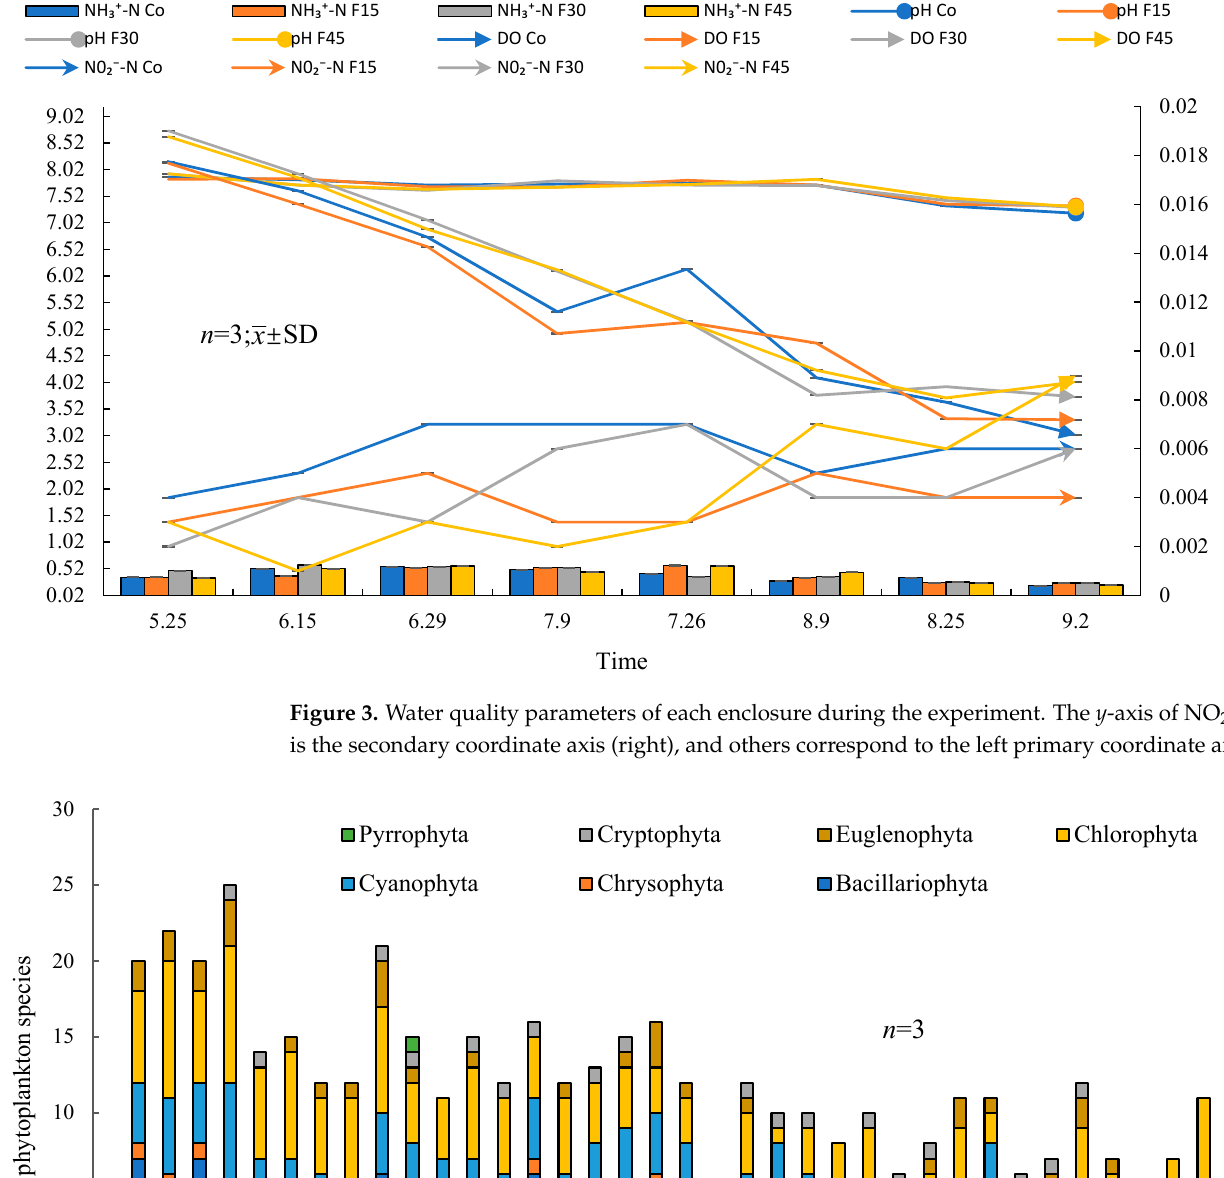
Figure 4. Species of phytoplankton observed in different treatment groups during the experiment. The phytoplankton diversity in each group was analyzed using the Shannon–Wiener diversity index (Figure 5), with an overall average of 1.07. The diversity index of the Co group was 0.59 to 1.43, with an average of 1.03. The diversity index of the T15 group was 0.46 to 1.62, with an average of 0.95. The diversity index of the T30 group was 0.54 to 1.65, with an average of 1.02. The diversity index of the T45 group was 0.93 to 1.62, with an average of